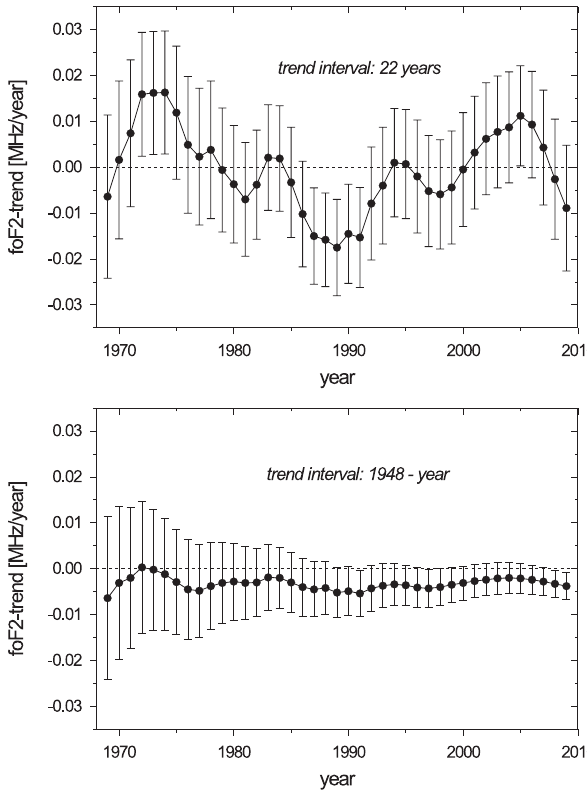
Fig. 10. Global mean hm F2 trends with error bars for constant in- tervals of 22 years continuously shifted by one year (upper part) and for intervals with increasing data length (lower part). The trend values are drawn in both cases at the upper end of the intervals in- vestigated.